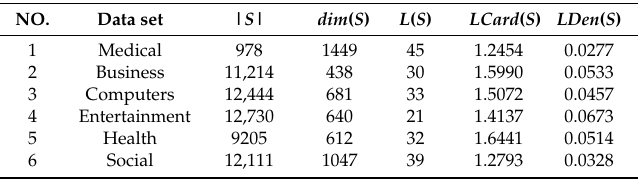
Table 1. Data sets